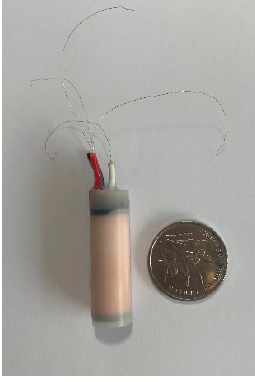
Figure 5. Photo of the single-component probe (a coin is used as a size reference).